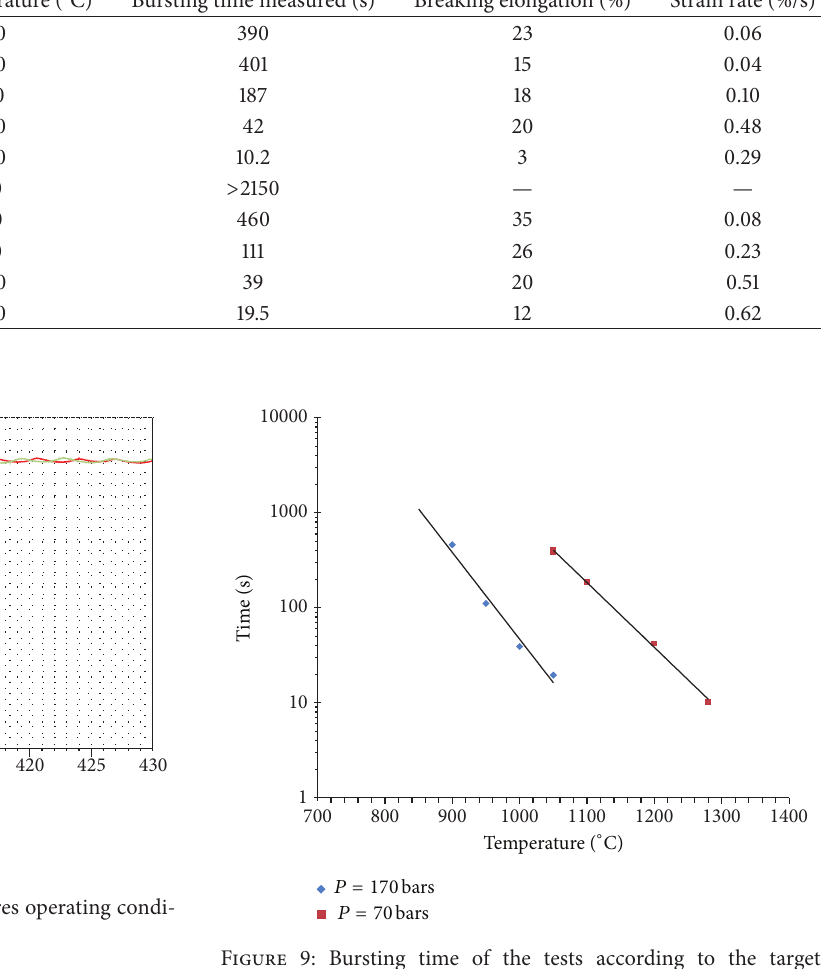
Figure 9: Bursting time of the tests according to the target